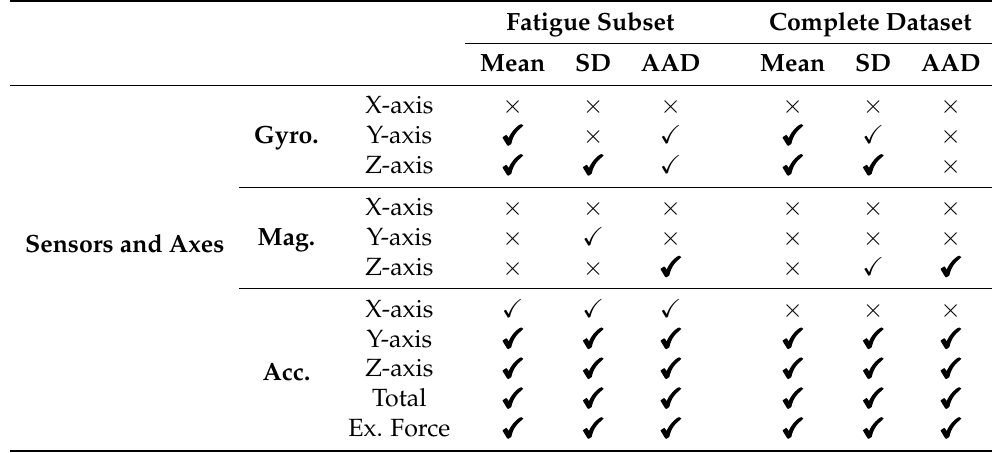
Table 5. Table of the significant ( (cid:88) ) and insignificant ( × ) features extracted from both fatigue subset and complete dataset; the overlapping features are in highlighted